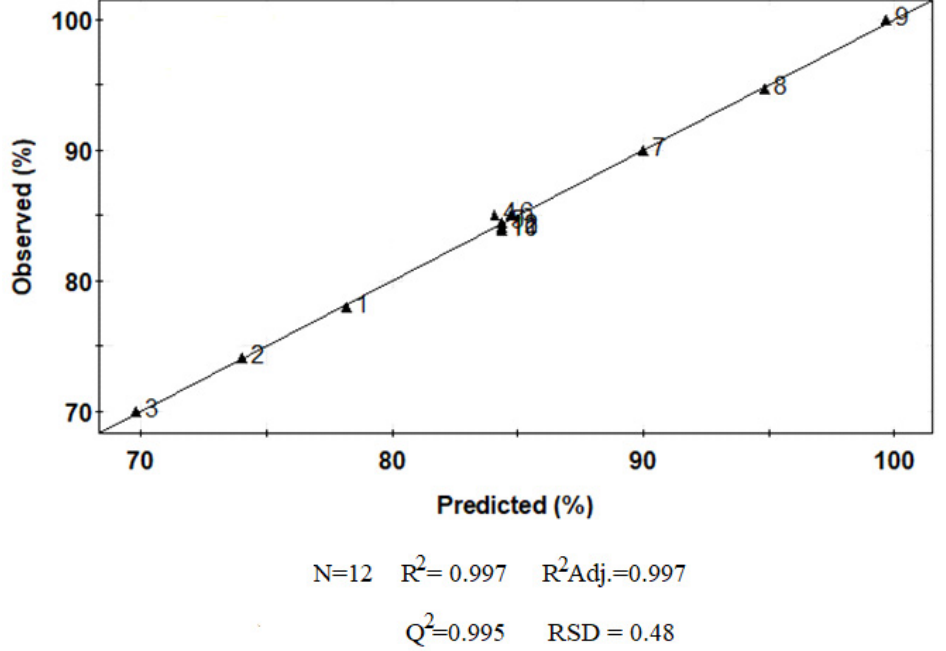
Figure 2. Observed versus predicted values of the response given by the experimental design for the bioremediation process optimization in the function of the variables pH and treatment time with the bacteria without